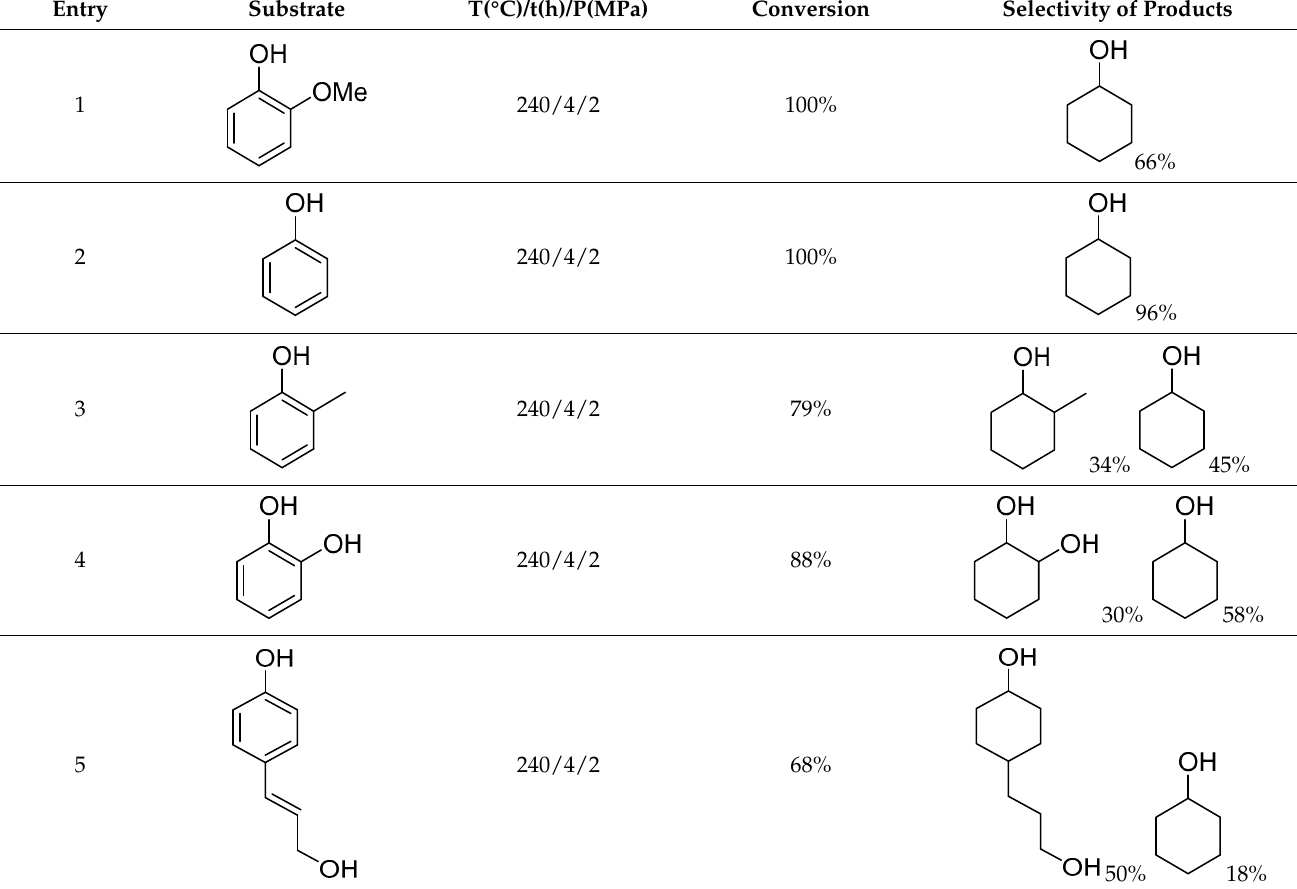
Table 3. Evaluation of the substrate scope in the HDO process over Ni3Mo1@C.